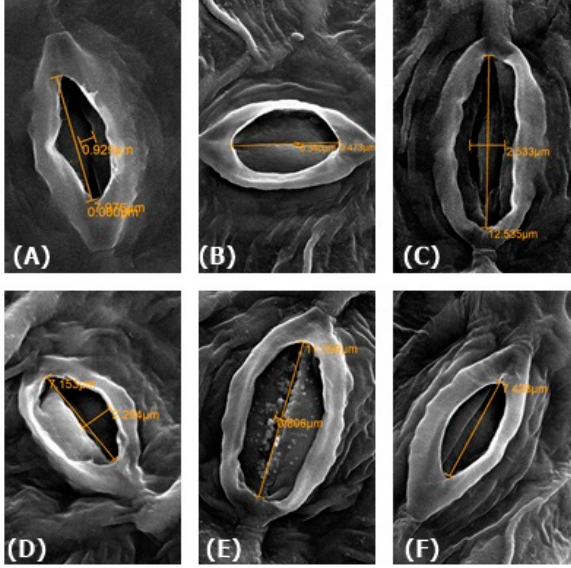
Figure 11. Stomatal response of Indian mustard ( Brassica juncea L.) leaves at 30 DAG under control ( A ), Cu ( B ), SNP ( C ), SNP + Cu ( D ), FCy + Cu ( E ) and SNP + Cu + cPTIO ( F ) at 4000 × using scanning microscope.